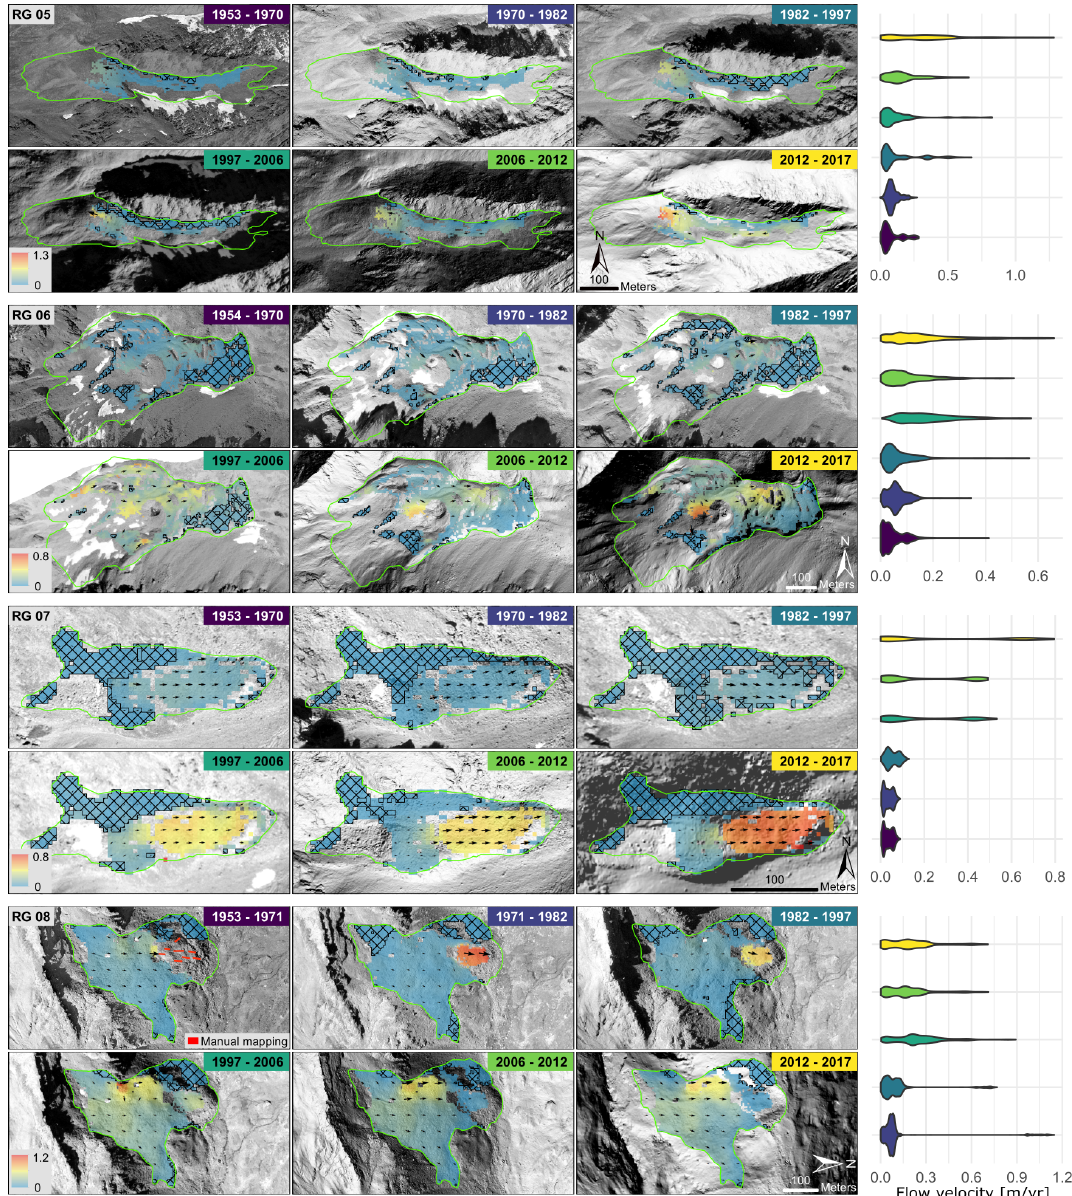
Figure 7. Maps and violin plots showing the flow velocities and their distribution for the individual rock glaciers for six epochs between 1953 and 2017. The units of the colour scales are metres per year. Areas with flow velocities below the LoD are marked with a black grid. The background image is always the older date of the time span. The colour of the violin plots corresponds to the colour of the respective time period in the maps. Violin plots show the kernel probability density of the data at different